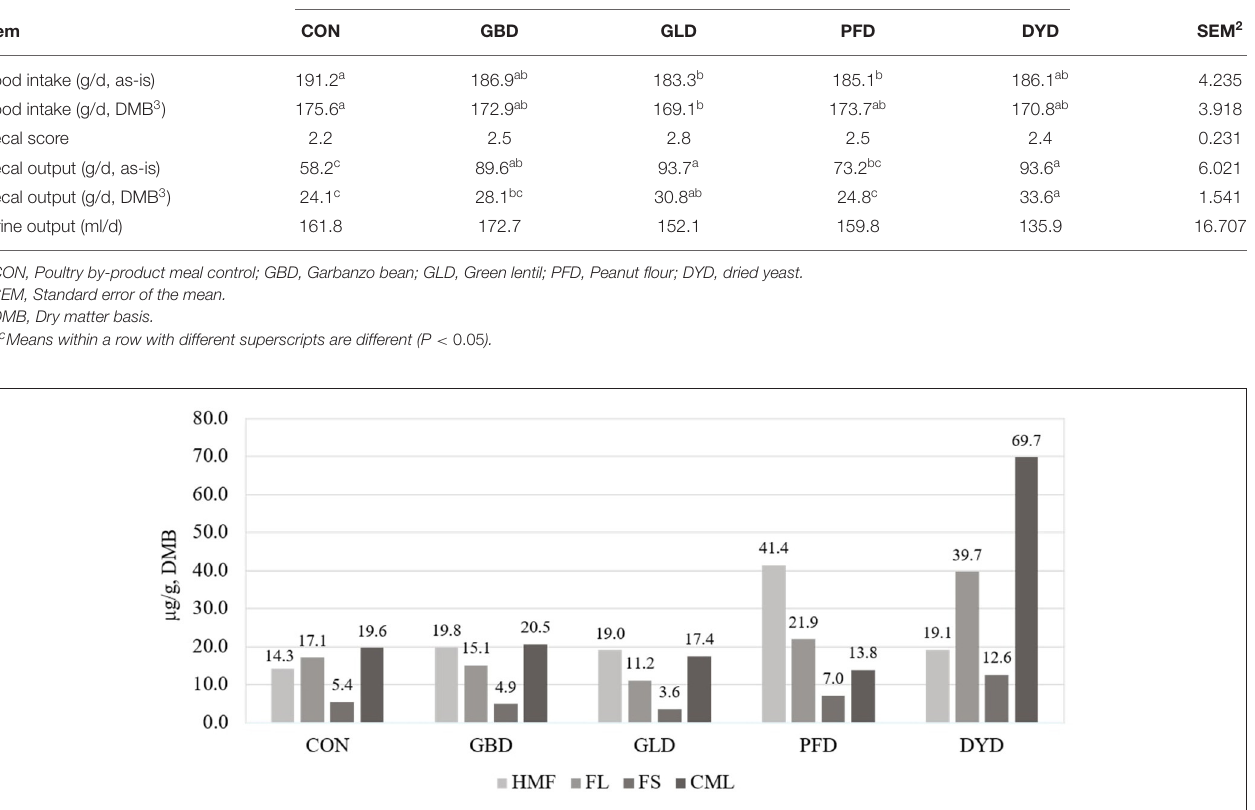
Dietary treatment 1